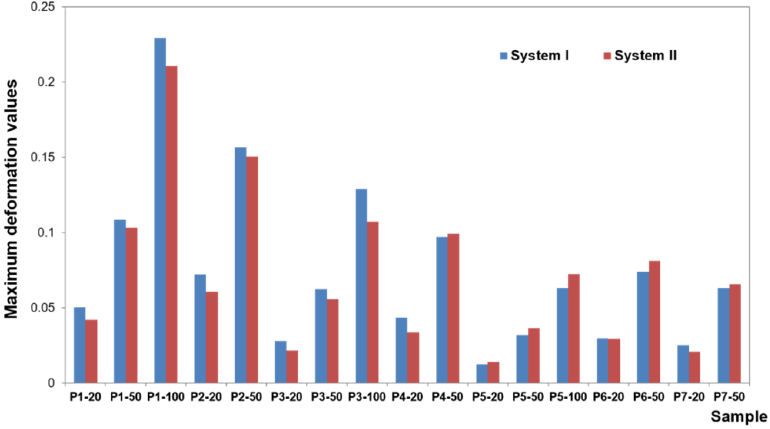
Figure 14. Maximum mucosa deformations for systems I and II.